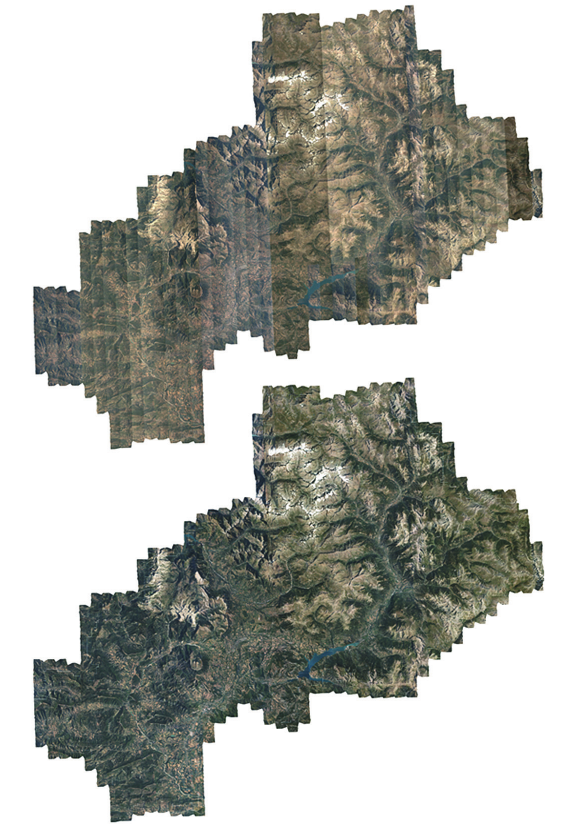
Figure 3. Continuum of aspect of signs assembled: Orthomosaic from hundreds of aerial frame images on a 6 000 km² area,